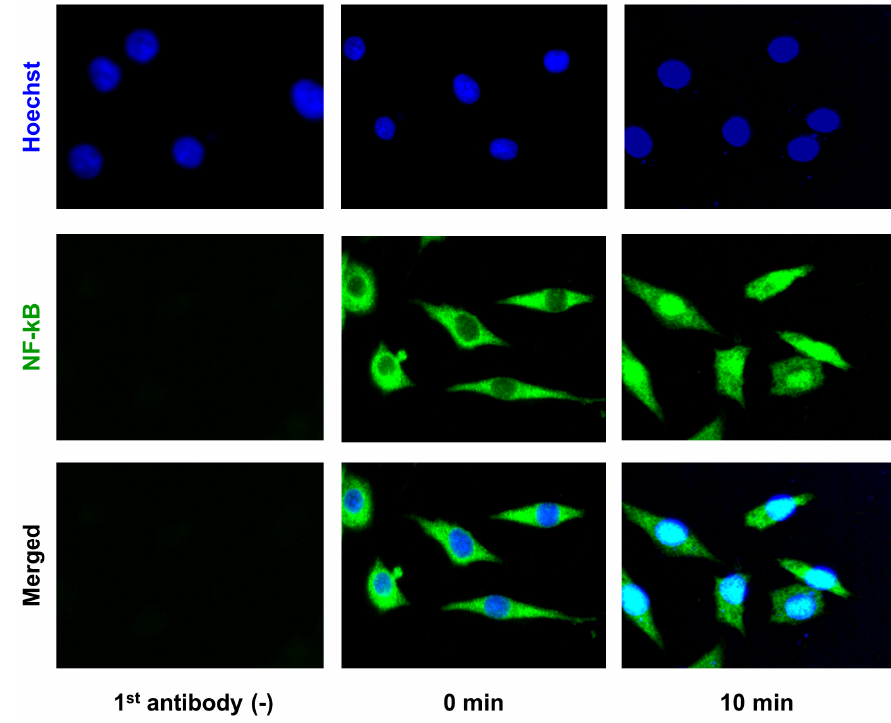
Figure 6. IL-1 β induces translocation of NF- κ B (p65) from cytoplasm to nucleus. OUMS-27 cells were seeded in collagen-coated chamber for 48 h. After 24 h of serum starvation, OUMS-27 cells were stimulated with IL-1 β for 12 h. NF- κ B p65 (green) was detected by immunocytochemistry (green) and nuclei were stained with Hoechst 33258 (blue). Merged images are shown at the bottom.